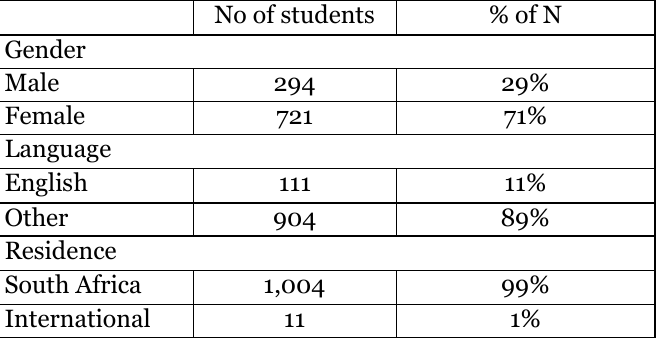
Composition of Population (N = 1,015: Source: Unisa Student Record System, 2013)